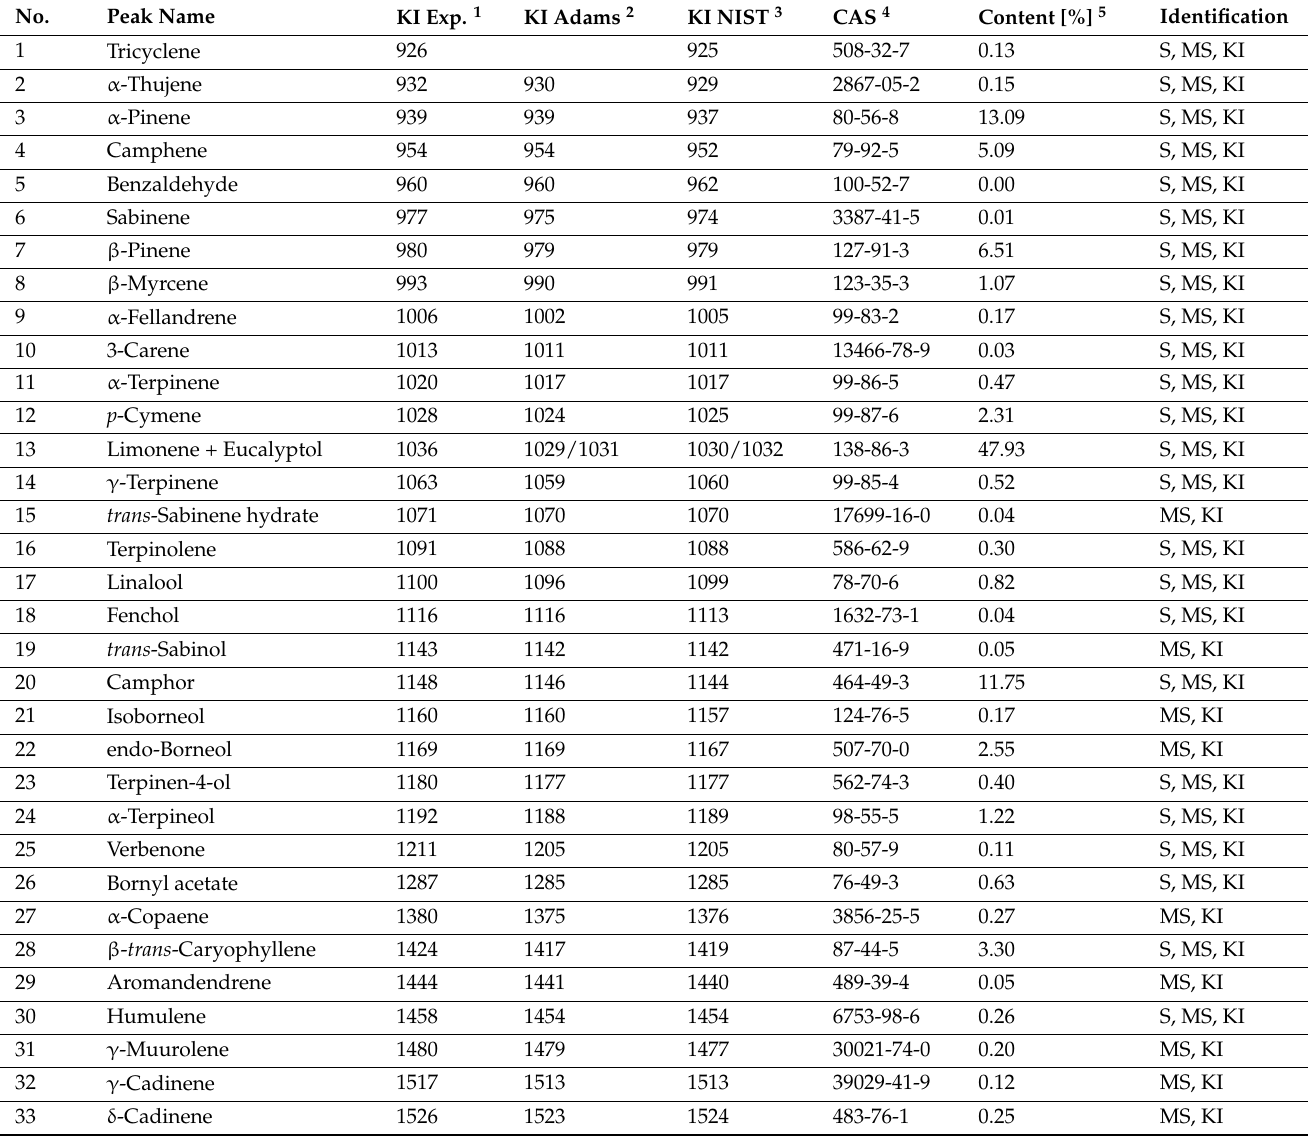
Table 14. GC-MS profile of rosemary essential